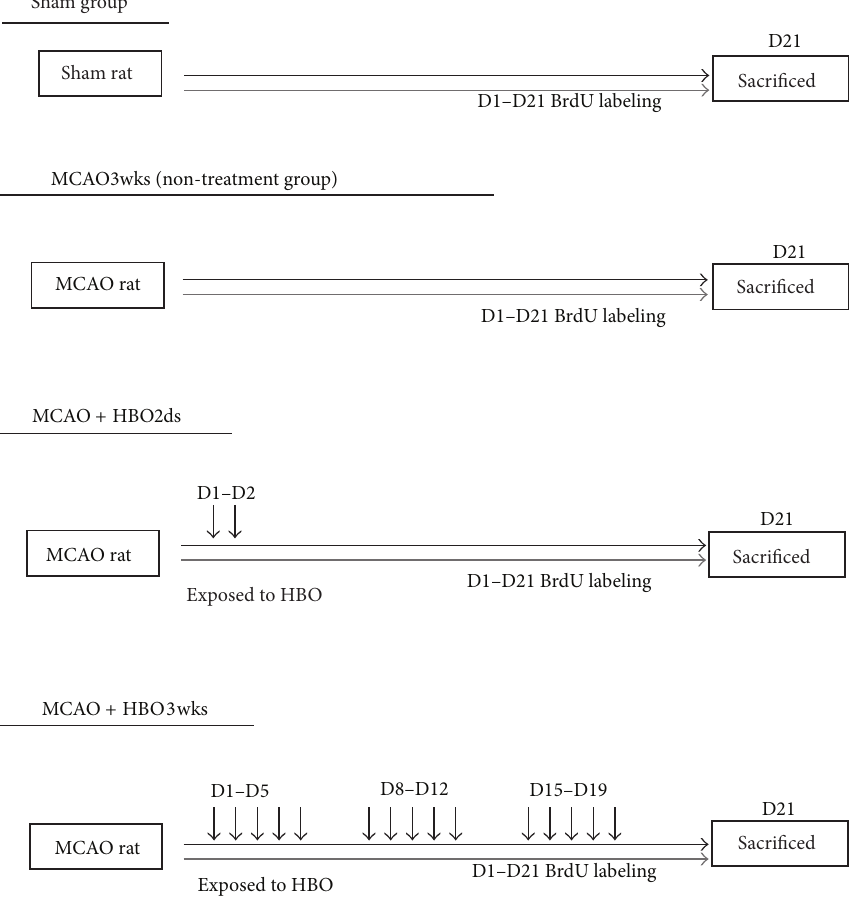
Figure 1: Demonstration of HBO treatment protocol in different